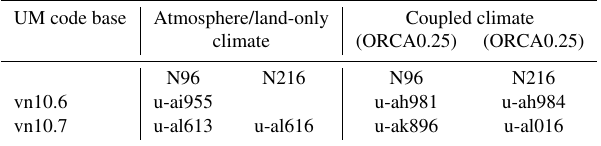
Table 10. Identifiers for a set of GA7.1/GL7.0 reference climate simulations across a number of UM code versions. These suites are held on the Met Office Science Repository Service, which also holds the UM and JULES code. Here, ORCA0.25 denotes a 0.25 ◦ × 0.25 ◦ NEMO ocean model